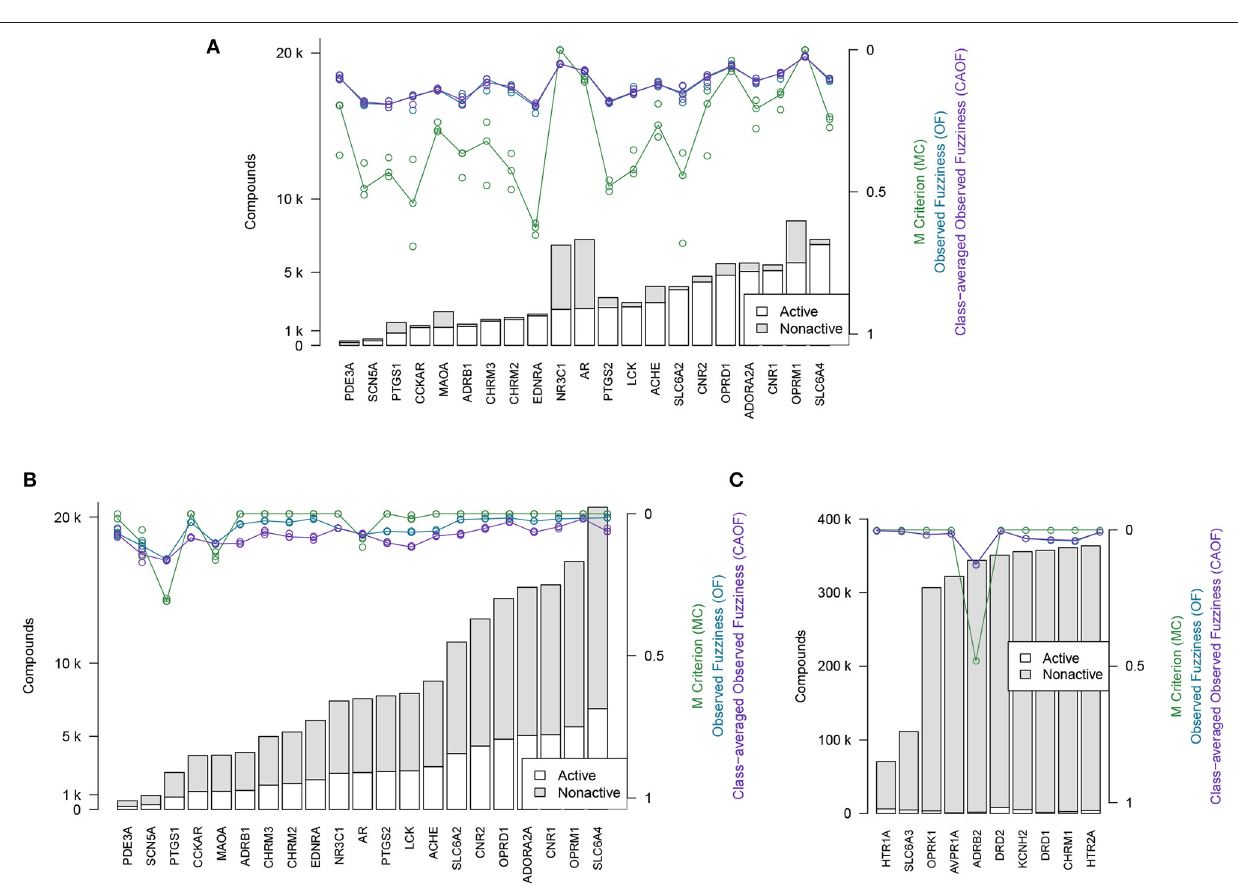
FIGURE 4 | Efficiency metrics (M Criterion, Observed Fuzziness and Class-Averaged Observed Fuzziness) for Dataset1, Dataset2, and Dataset3. (A) Dataset2 without extending with assumed non-actives. Circles show individual results from the three replicate runs that were run, while the lines show the median value from the individual replicate results. Targets are here sorted by number of active compounds. (B) Dataset2 after extending with assumed non-actives. Circles show individual results from the three replicate runs that were run, while the lines show the median value from the individual replicate results. Targets are here sorted by number of active compounds. (C) Dataset3, the 10 largest target datasets, which were not extended with assumed non-actives. Targets are here sorted by total number of